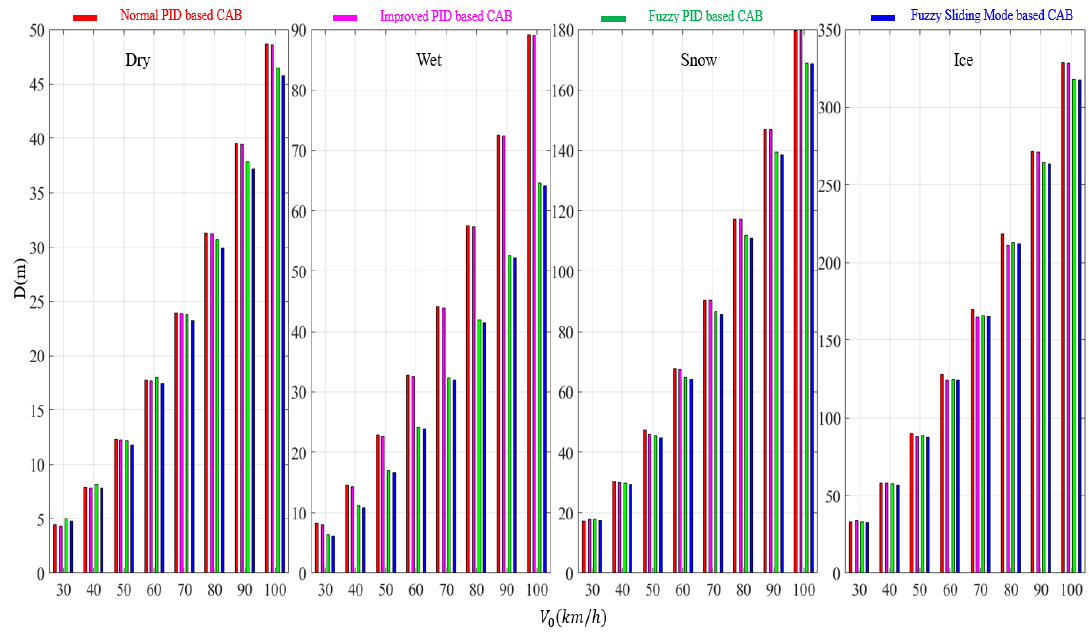
Figure 5. The D comparison under different CABs on various road conditions.